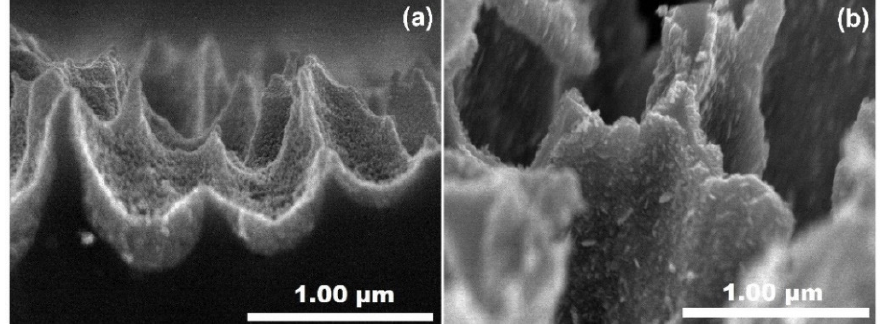
Figure 4. SEM micrographs of cross-sectional images with higher magnifications corresponding to Z1P ( a ) and Z2P ( b ). Z1P ( a ) and Z2P ( b